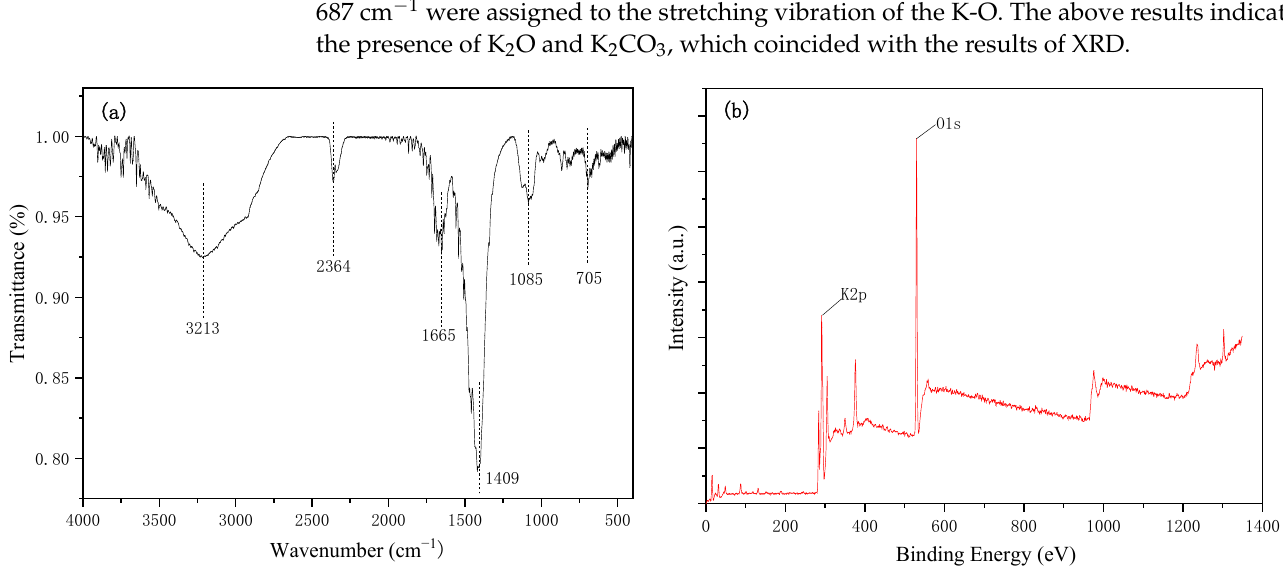
Figure 4. The FT-IR results ( a ) and XPS analysis of the DN-350 catalyst ( b ). XPS analysis was conducted to further detect the element state on the surface of catalyst. As shown in Figure 4b, the dominating components were C (40.33%), O (32.27%), and K (12.23%). It is worth noting that two binding energies of K 2p can be ob- served to be 291.6 eV and 294.2 eV, suggesting the coexistence of both K 2 O and K 2 CO 3 on the surface of catalysts, which was entirely consistent with the previous results.